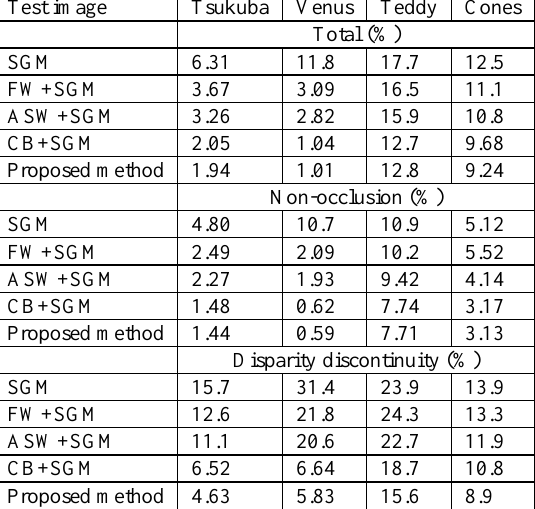
Table 2. The proportion of the disparity error (> 1